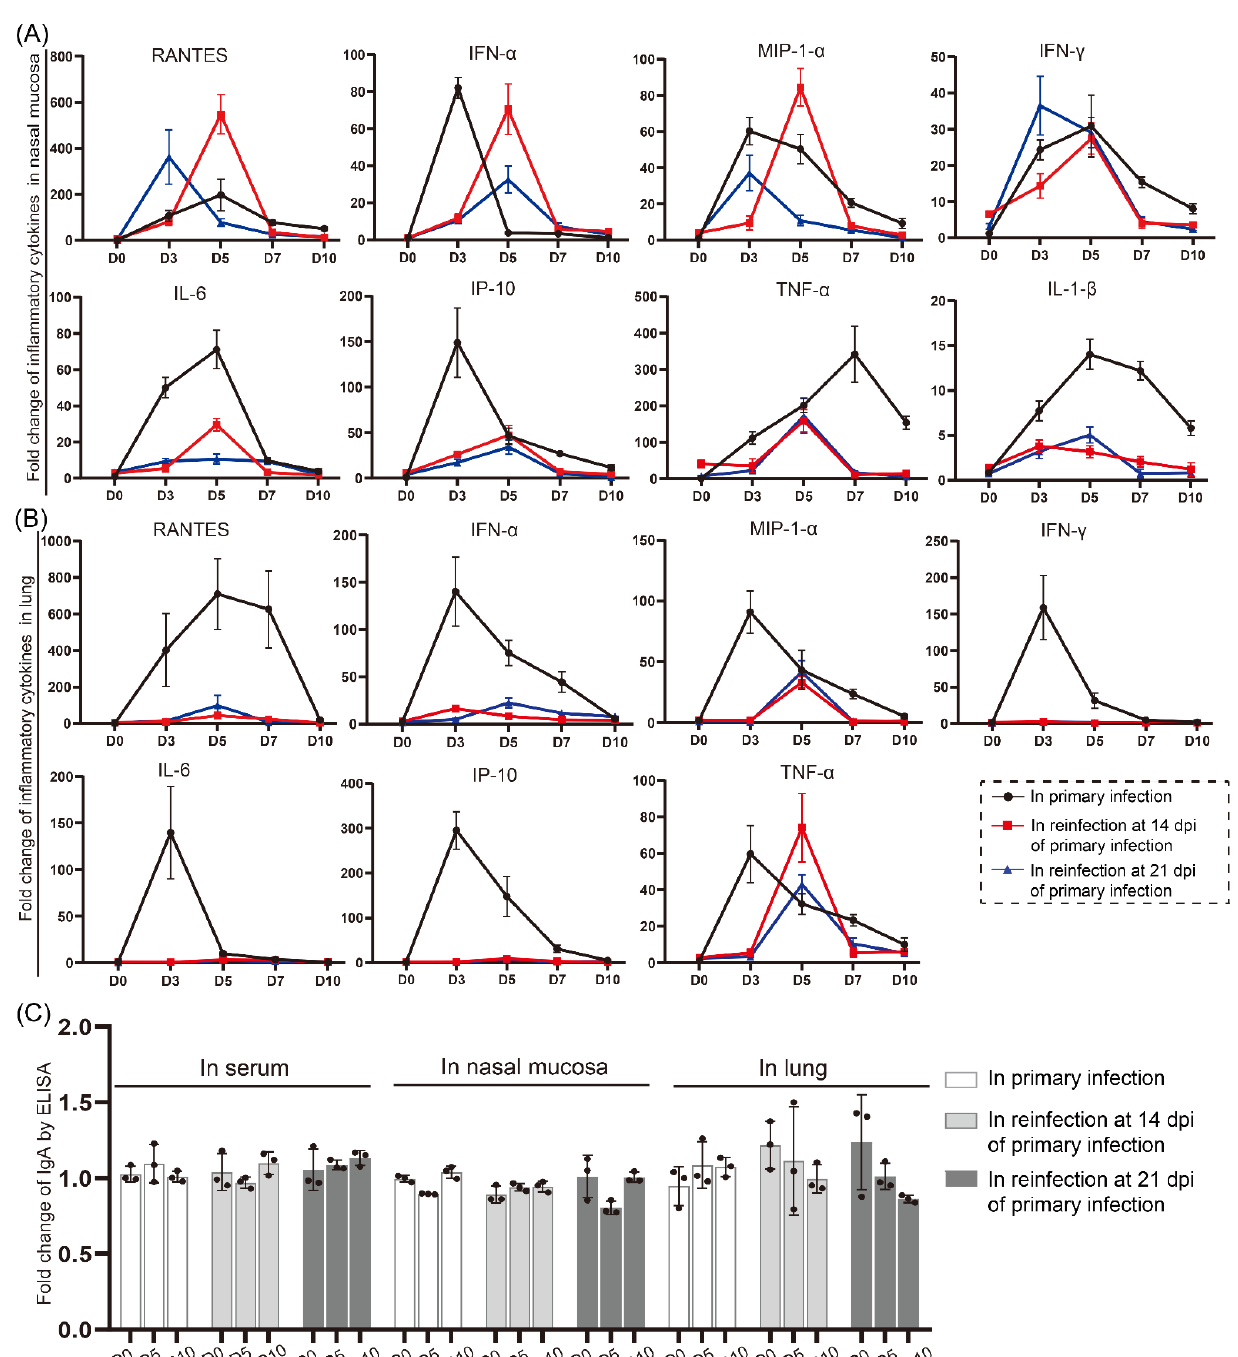
Figure 8. Cytokine/chemokine responses in the nasal mucosa during reinfection were similar to those during primary infection. ( A , B ) The mRNA expression levels of cytokines and chemokines, including RANTES, IFN- α , MIP-1- α , IFN- γ , IL-6, IP-10, TNF- α , and IL-1- β , were detected by real-time PCR in the nasal mucosa ( A ) and lung ( B ) during SARS-CoV-2 primary infection and reinfection. ( C ) The levels of IgA in the serum, nasal mucosa, and lung during the infection process of primary and secondary infection were detected by ELISA, there was no significant difference between primary infected group and reinfected group calculated by one-way ANOVA using SPSS PASW statistical software version 18.0. “ ●” in the image represents the data in every hamster, and the bars were calculated by GraphPad Prism 8 to reflect the data uniformity. n = 3 at every point.